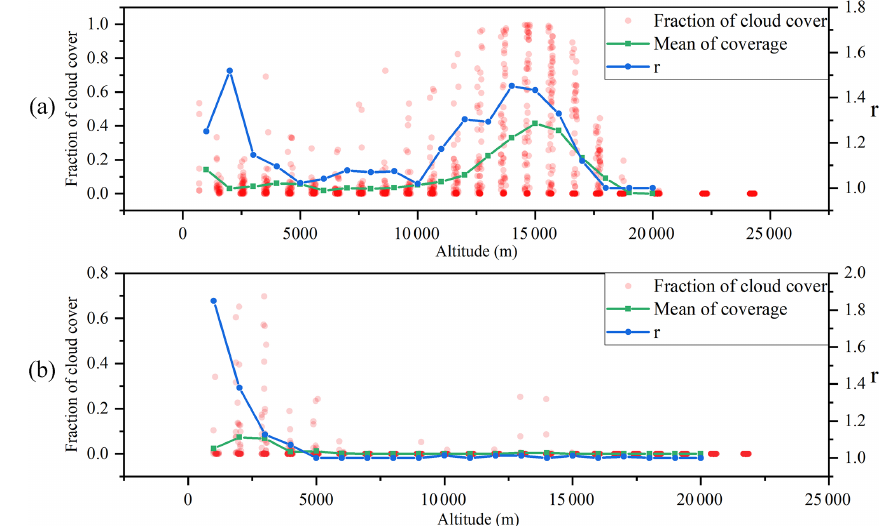
Figure 13. ERA5 cloud coverage of the valid Rayleigh channel data in the vertical direction. Data in (a) are from Qingyuan in July 2019, and data in (b) are from Qingyuan in December 2019. The green line is the mean value of cloud coverage at different distance gates.